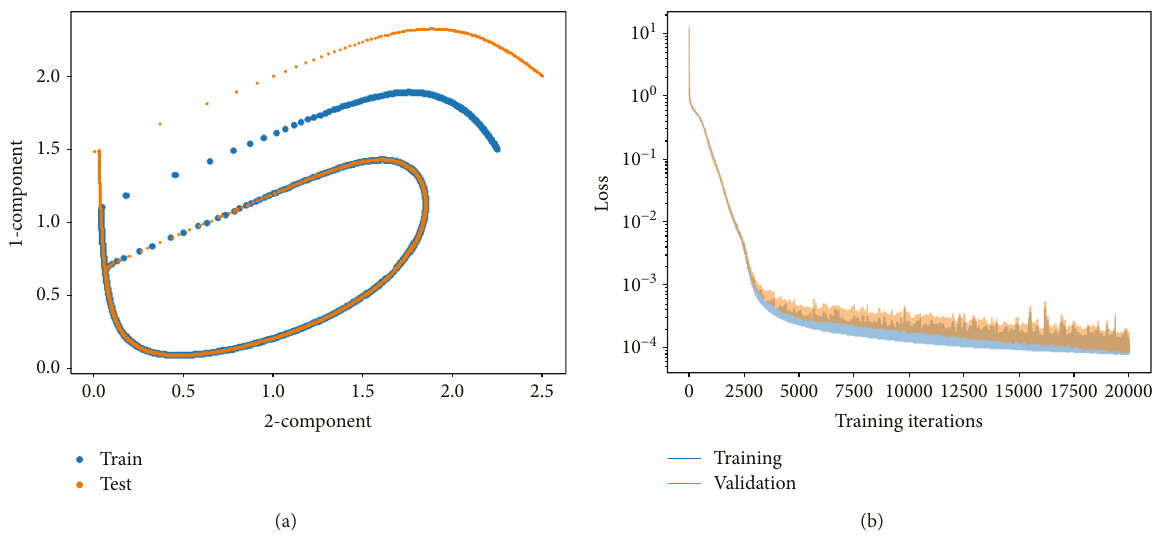
Figure 7: Nonrational nonpolynomial case. (a) Data distribution of training/testing feature. (b) Learning curve.